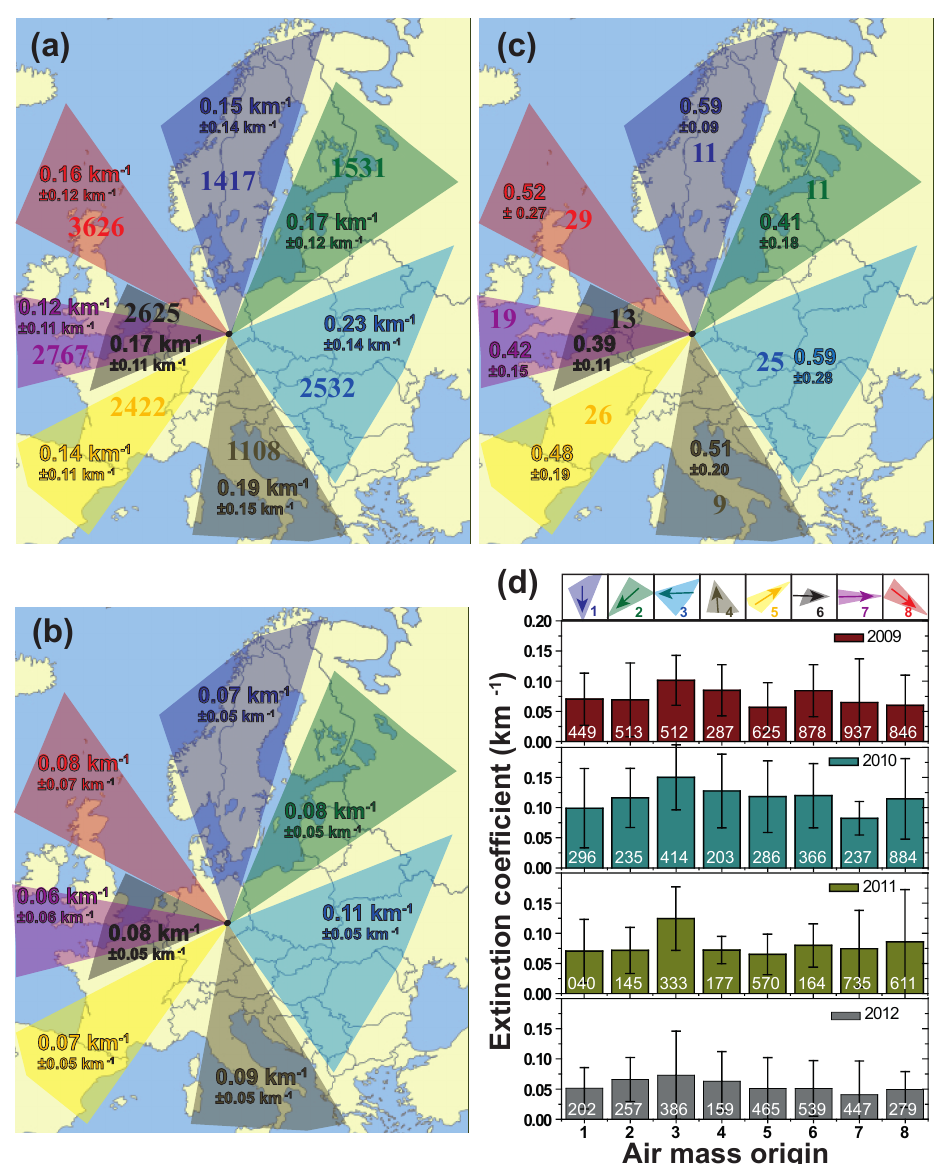
Figure 7. (a) Extinction coefficient for 550nm (mean value, SD, number of measurements) for eight defined air-mass transport regimes based on SÆMS observations from 2009 to 2012, (b) same as (a) , except prior to averaging all individual cases were normalized for dry conditions (RH = 0%) by use of the derived cluster mean parameter γ (c) and (c) hygroscopic exponent γ for 550nm (mean value and SD, computed with Eq. 3) for the eight air-mass transport regimes derived from SÆMS observations from 2009 to 2012. Numbers of available cases per cluster are given in addition, and (d) same as (b) , but separately for dry conditions (RH = 0%) for each year of the period from 2009 to